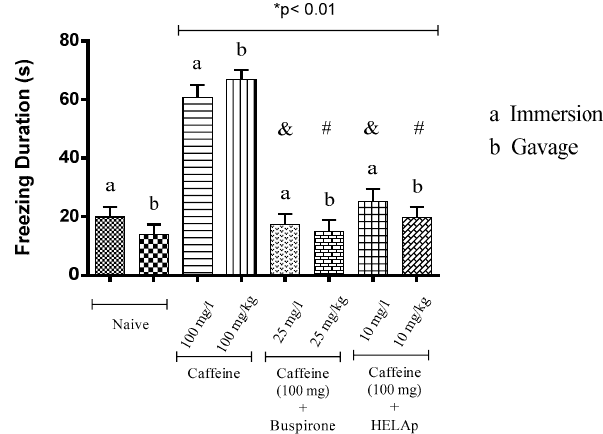
Figure 6. Effects of the hydroethanolic extract from A. polystachya , buspirone, and caffeine on zebrafish behavior in the scototaxis test (freezing duration) using immersion and oral (gavage) administration. Data are presented as mean ± SEM (n = 4/groups); * p < 0.01 vs. naive fishes; & p < 0.01 vs. caffeine immersion; # p < 0.01 vs. oral caffeine administration. Statistical analysis was performed through one-way ANOVA followed by the post-hoc Tukey test.